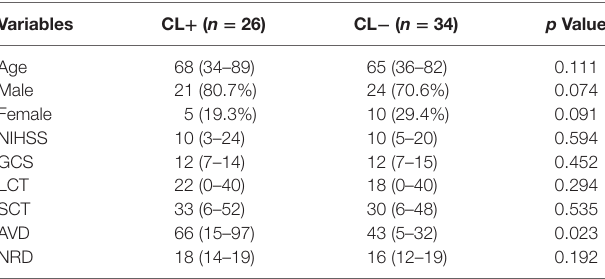
TaBle 3 | Binary logistic regression according to the crossed leg with USN degree corrected by clinical and anthropometric variables.